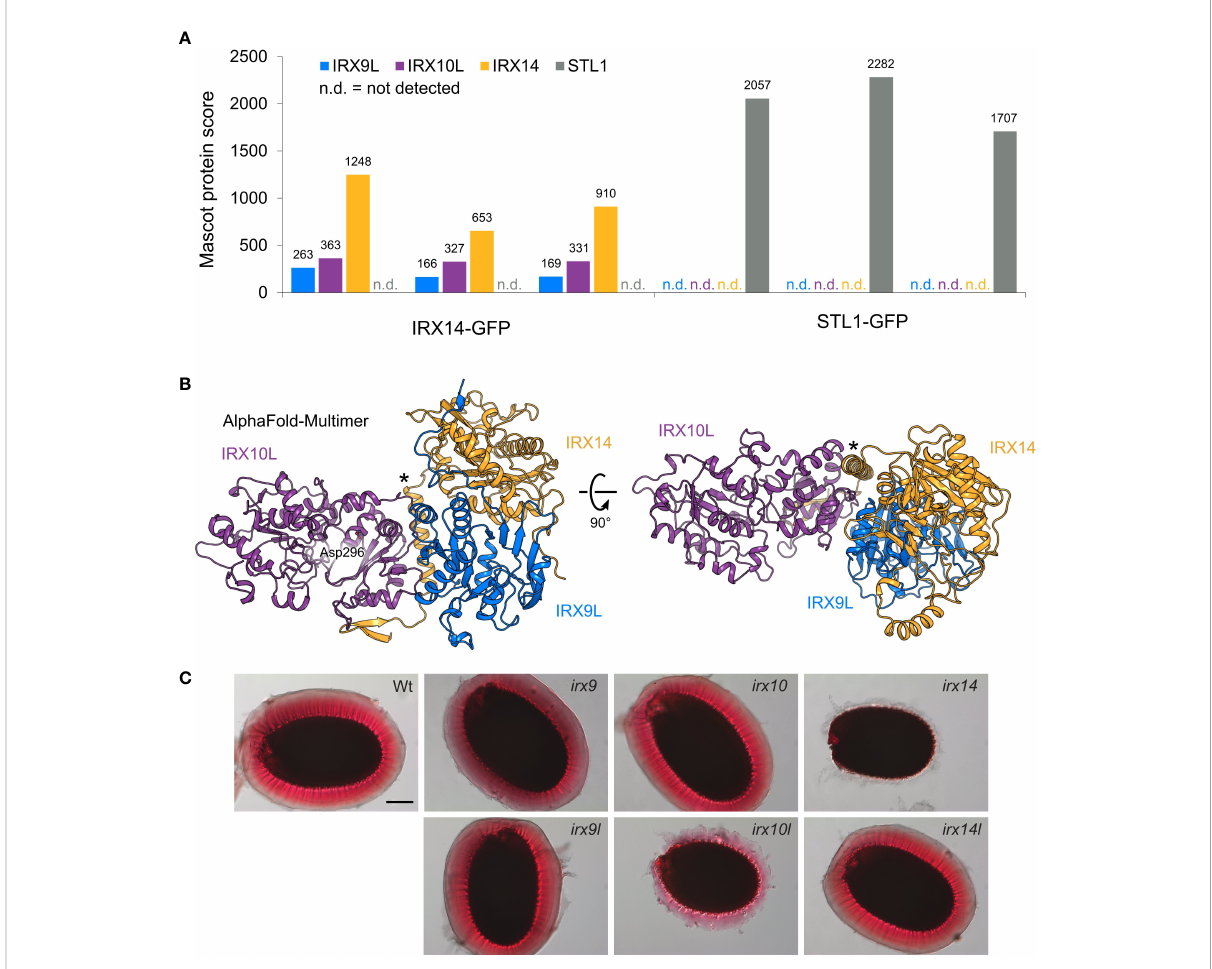
FIGURE 1 The XSC in primary cell wall xylan synthesis in Arabidopsis. (A) Anti-GFP immunoprecipitation of the XSC in Arabidopsis root callus. Mascot protein scores for IRX9L, IRX10L, IRX14 and STL1 (control) are shown for three biological replicates using IRX14-GFP ( left ) or STL1-GFP (control, right ) as bait, respectively. (B) AlphaFold-Multimer model of a heterotrimer of the IRX9L (blue), IRX10L (violet), and IRX14 (yellow) globular domain. A putative nucleotide-binding residue, Asp296 (Wilson et al., 2022), is shown in IRX10L. Note the predicted a -helix of IRX14 at the interaction surfaces of both IRX9L and IRX10L (asterisk). (C) Phenotype of the adherent mucilage of XSC mutants. Mucilage is stained with ruthenium red. Wt: Columbia Col-0 wildtype control. Scale bar = 100